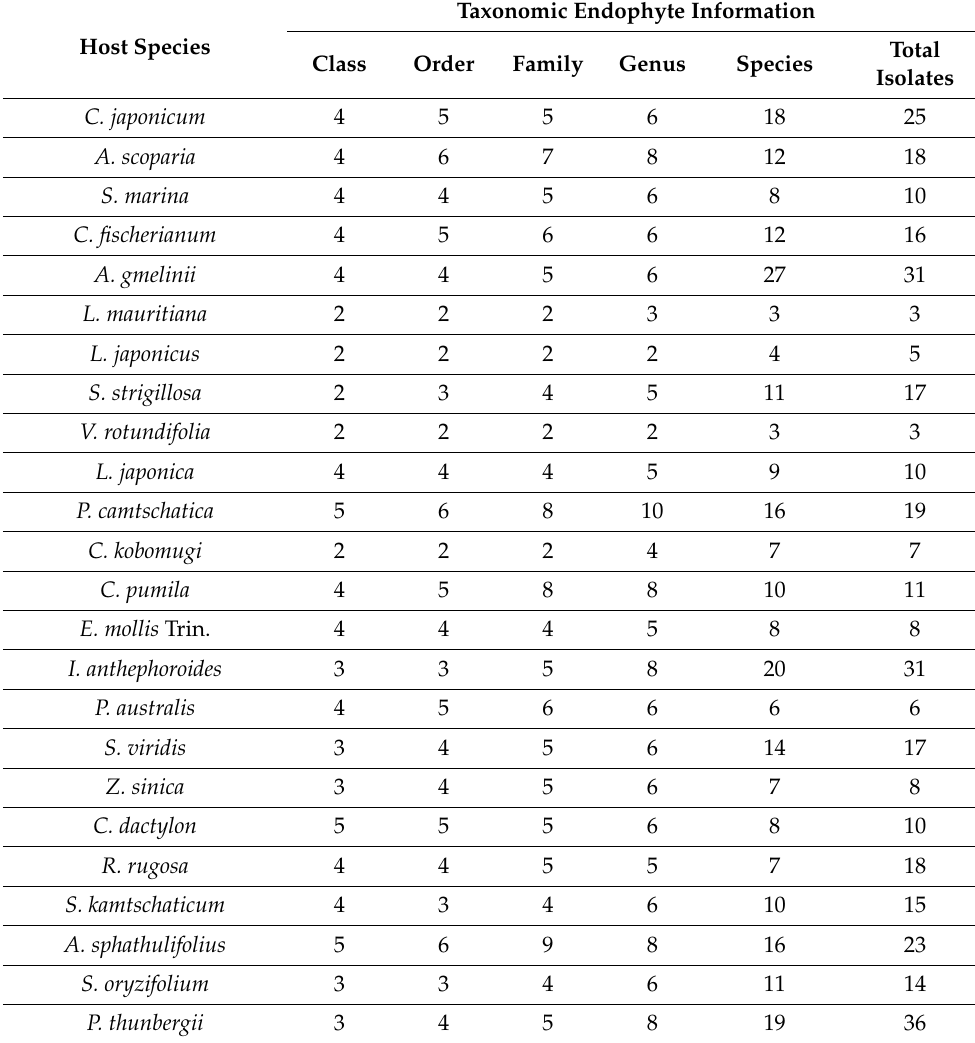
Table 2. Taxonomic identity of endophytes isolated from each host halophyte species. Taxonomic Endophyte Host Species